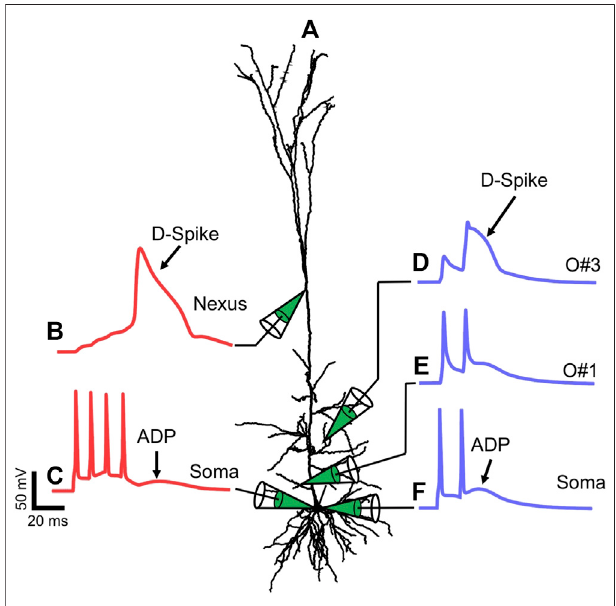
FIGURE1| DendriticspikesgeneratedfromtheL5PNmulti-compartment should be in one line (move the compartment to the above line) model. (A) The morphology of the L5PN used in the model. The membrane potential at (B) the nexus of the apical tuft and (C) the soma during a four-AP train with frequency f (cid:1) 100 Hz.Themembranepotentialattheobliquedendrites (D) O#3; and (E) O#1, and at the (F) soma during a two-AP train with f (cid:1) 70